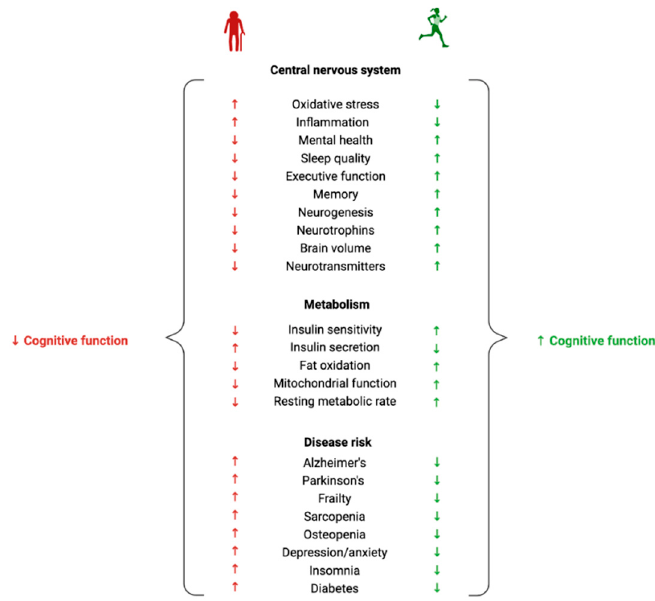
Figure 1. Effects of exercise on age-associated physiological changes. See Chodzko-Zajko et al. [17], Garatachea et al. [18] and Carapeto and Aguayo-Mazzucato [19] for comprehensive reviews of the anti-ageing effects of